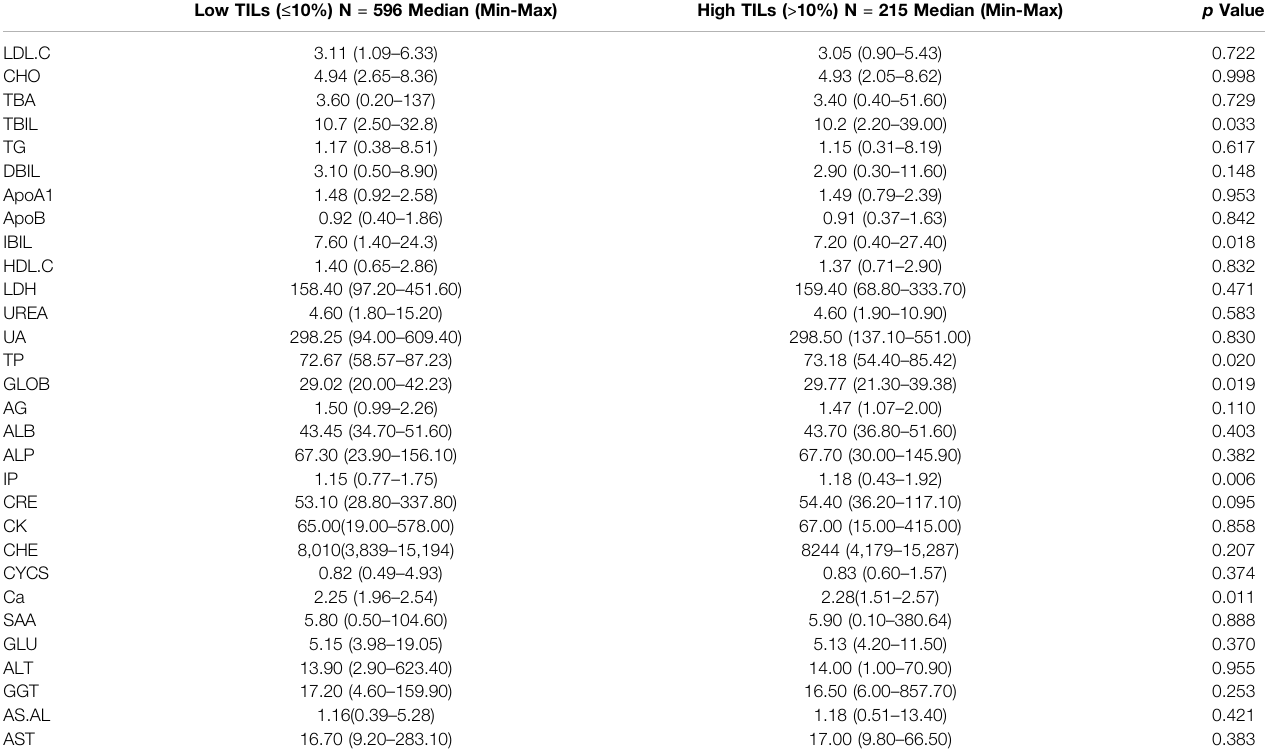
TABLE 3 | correlations between blood biochemistry and TILs.